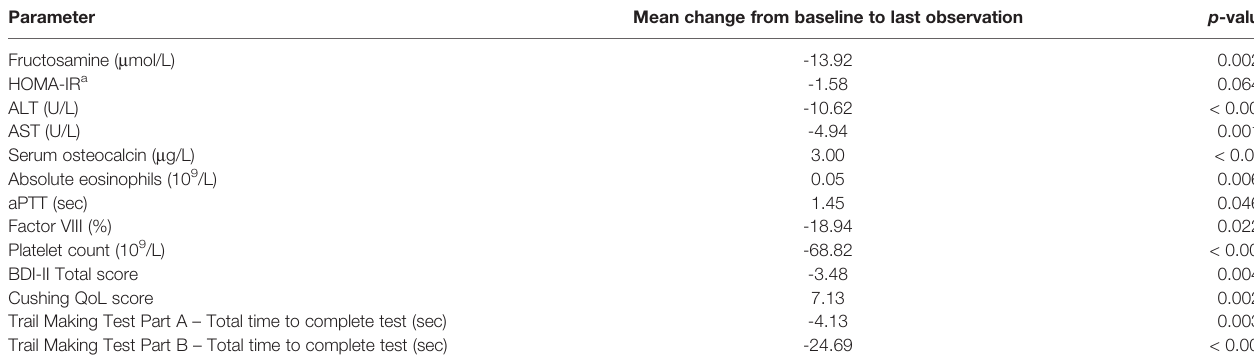
p-values for the mean change from baseline to last observation are from the Wilcoxon signed-rank test. a A signi fi cant difference was observed in the high-dose treatment group (mean change -3.2, p = 0.033). ALT, alanine aminotransferase; aPTT, activated partial thromboplastin time; AST, aspartate aminotransferase; AUC, area under the curve; BDI, Beck Depression Inventory; HOMA-IR, homeostatic model assessment for insulin resistance; QoL, quality of life.